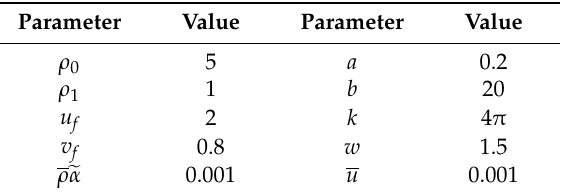
Table 1. Parameters and values for the 2-D